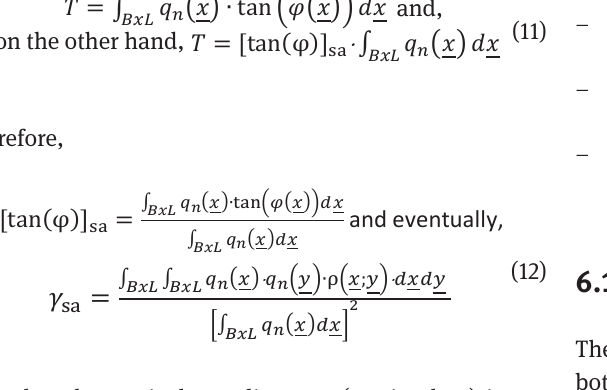
Figure 3: The dimensionless variance reduction factors g depending on the correlation parameter d = d eccentricities e